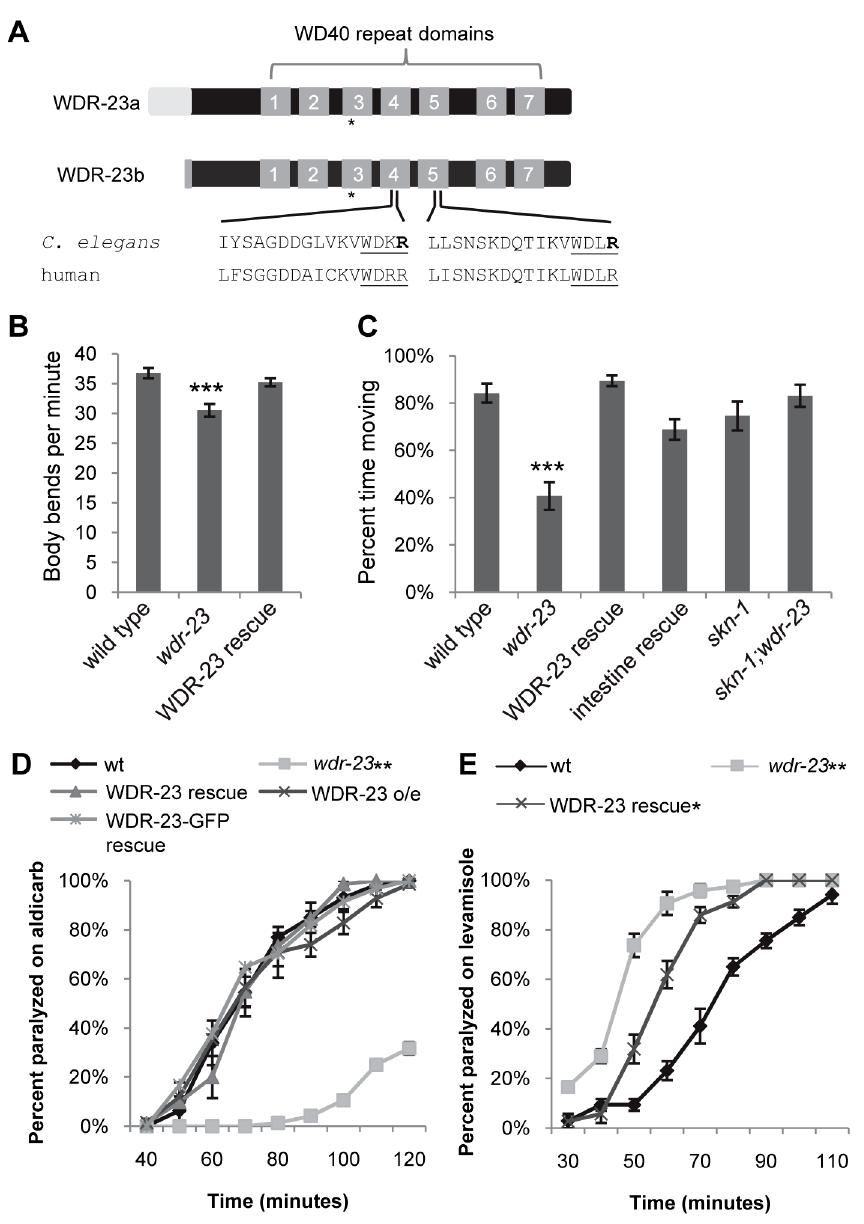
Figure 1. wdr-23 mutants display locomotion defects. (A) Schematic of WDR-23 isoforms used in this study. Asterisk denotes location of premature stop in the wdr-23(tm1817) allele. The seven WD40 repeat domains and the conservation of the DDB1 binding sequences are identified. The Arg (R) residues which were mutated to His (H) to create WDR-23(DxR) are indicated in bold font. (B) Body bends per minute of the indicated strains. WDR-23 rescue denotes wdr-23 mutants expressing transgenes containing wdr-23a cDNA under control of the wdr-23 promoter. Locomotion was quantified in one minute intervals in the absence of food (Student’s t- test). (C) Percent time spent in locomotion of the indicated strains. wdr-23a cDNA was used for rescue with either the endogenous wdr-23 promoter (WDR-23 rescue) or the ges-1 promoter (intestinal rescue). The skn-1 allele zu67 was used for movement analysis. Animals were assayed for three minute intervals in the presence of food. (ANOVA, Tukey’s post-hoc). (D) Rates of worm paralysis of the indicated strains when exposed to the acetylcholine esterase inhibitor aldicarb (1.0 mM). Wild type indicated by wt. WDR-23 rescue and over-expression (o/e) were completed using a genomic wdr-23 fragment. WDR-23-GFP rescue denotes co-injection of wdr-23a and wdr- 23b cDNA driven by the wdr-23 promoter. (E) Rates of worm paralysis of the indicated strains when exposed to the cholinergic agonist levamisole (200 m M). WDR-23 rescue denotes wdr-23 mutants expressing genomic wdr-23 transgenes. (Error bars indicate 6 SEM. * p , 0.05, ** p , 0.01, *** p , 0.001.) doi:10.1371/journal.pgen.1003354.g001 Figure S1B and S1C). None of the skn-1 mutants examined negatively regulate SKN-1a and/or SKN-1c, and increased SKN- 1a/c activity leads to defects in synaptic function. Consistent with displayed significant size, growth, locomotion or aldicarb response defects alone (Figure 2B and 2C, Figure S1B, and data not shown). this idea, skn-1 gain-of-function (gf) mutants, which are predicted These results suggest that the primary function of WDR-23 is to to enhance the activity of SKN-1a and SKN-1c isoforms [27],